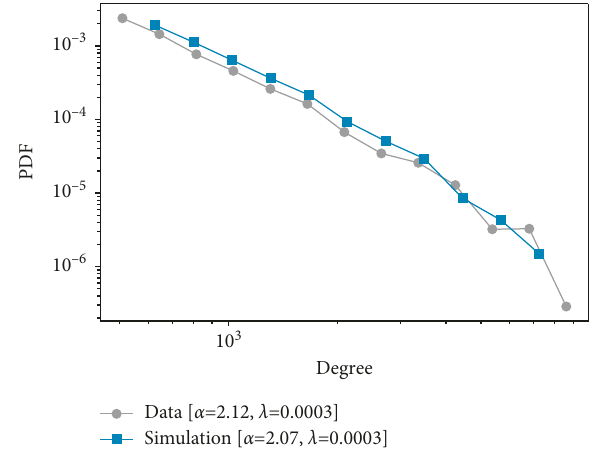
Figure 12: Comparison of degree distribution of real network (left) and simulation network